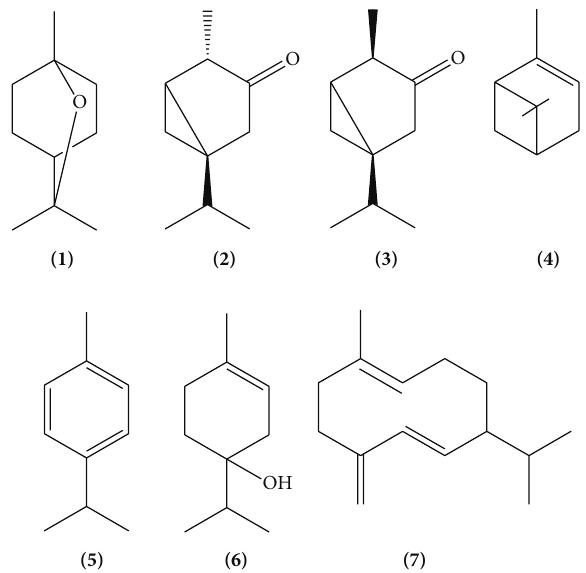
Figure 1: Chemical constituents identified by GC-MS in the essential oil of T. vulgare